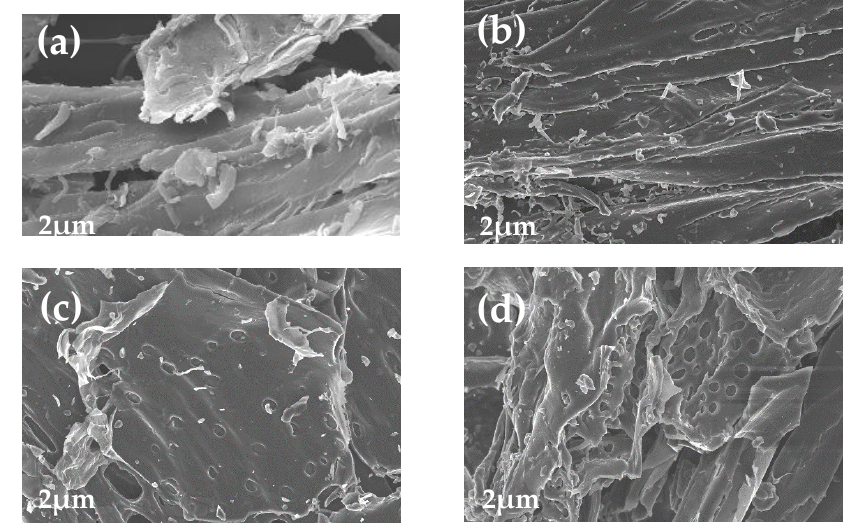
◦ C, ( c ) char 600 ◦ C, ( d ) char 700 ◦